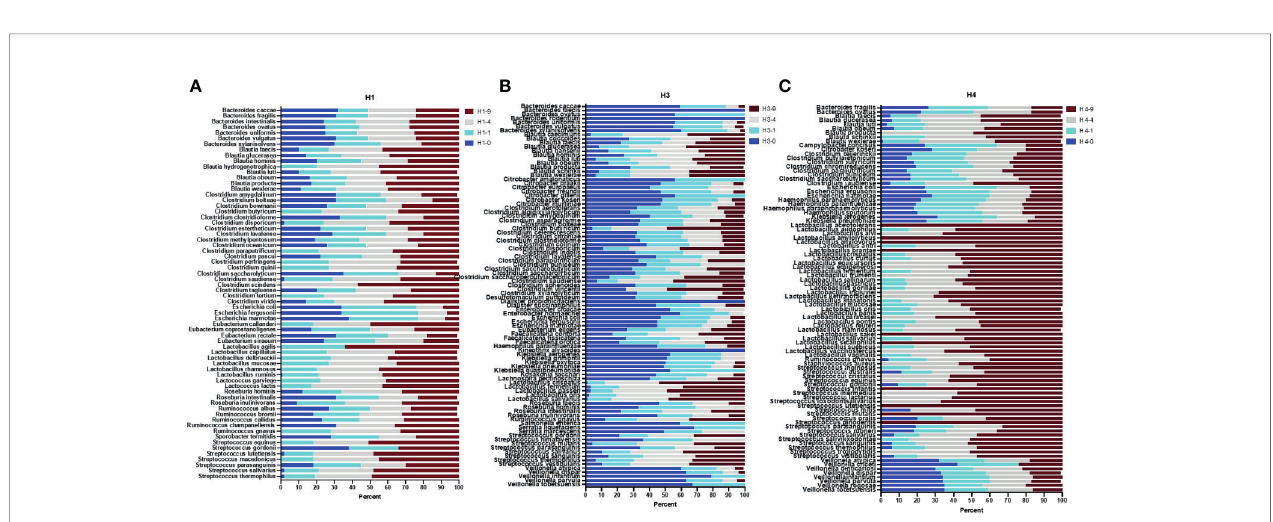
FIGURE 4 | Full length 16S rRNA gene sequence-based taxonomic classi fi cation of bacteria in human stool samples. Plots in panels (A – C) show relative abundance of detected species at four bead-beating conditions in H1, H3, and H4 stool, respectively. The x-axis shows the percentage of reads supporting the taxon and the y-axis shows detected species. In the sample ID, H represent Human and -0, -1, -4, and -9 represent bead-beating time in the